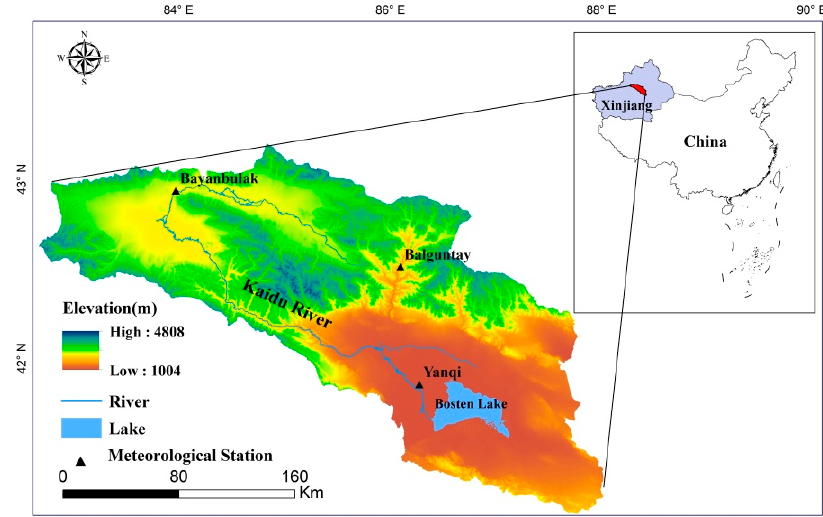
Figure 1. The geographical location of the Bosten Lake basin.